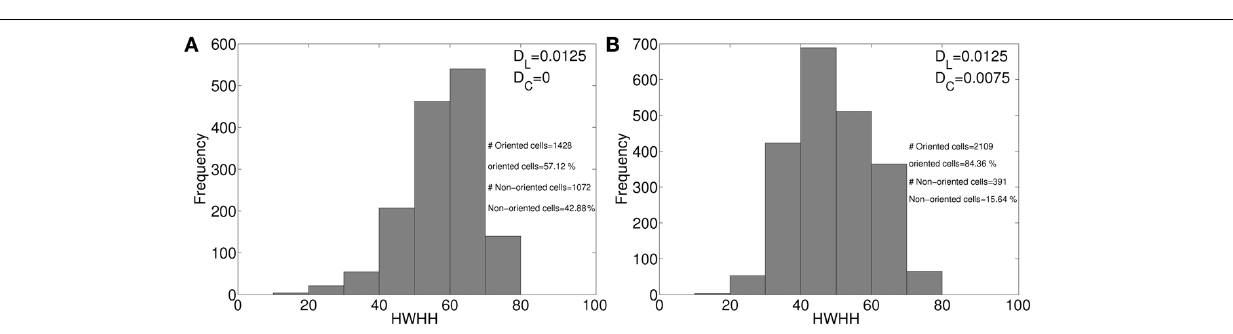
FIGURE 10 | HWHH histogram in model cat cortex, (A) in absence, and (B) in presence of diffusive cooperation among cortical